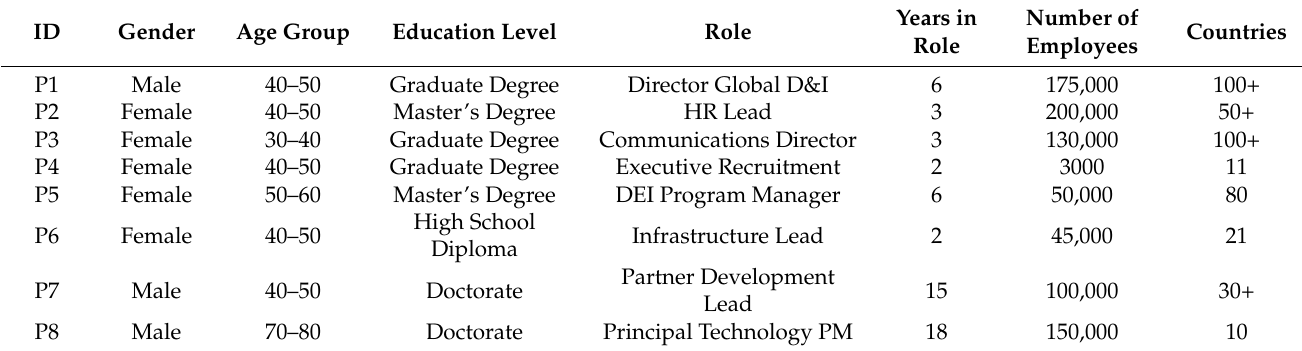
Table 1. Participant and company